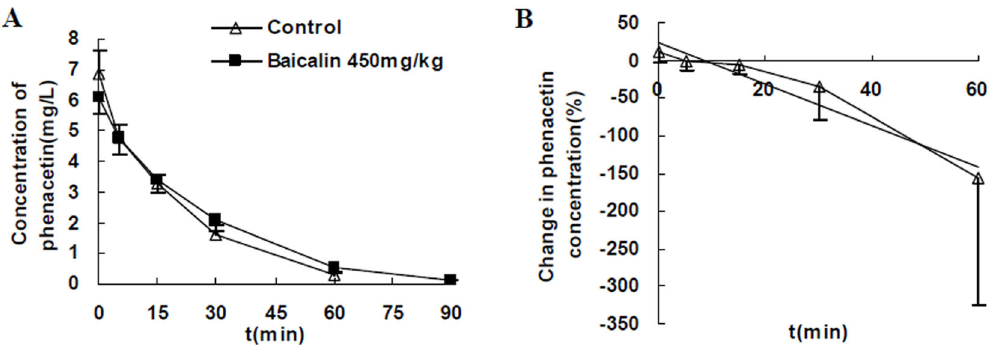
Figure 3. Effects of baicalin treatment on phenacetin pharmacokinetics. (A) The concentration-time profiles of phenacetin (5 mg/kg,i.v.) after treatment with normal saline (control) or baicalin (450 mg/kg, i.v.) in rats. (B) The changes in concentrations(%)-time profile of phenacetin (5 mg/kg, i.v.) after treatment with baicalin (450 mg/kg, i.v.) compared with control. Each point represents the mean 6 SD (n=11).